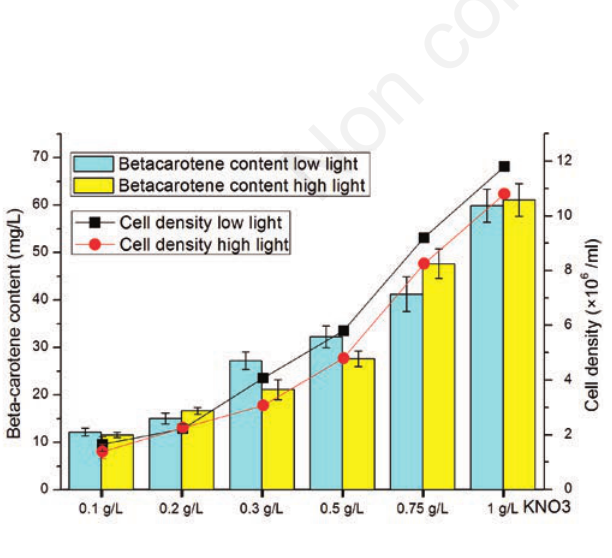
Figure 2. The cell density and beta-carotene content under differ- ent light intensity and KNO supplemented every two days for maintaining the same concen- tration as the first day; all values were collected at 15 th cultivation day.